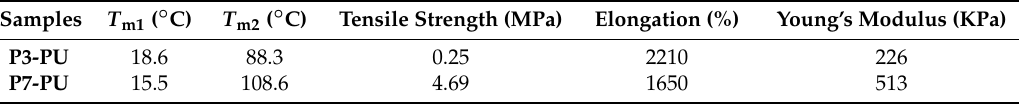
Figure 7. DSC curves of P3-PU and P7-PU . Table 2. Thermal and mechanical properties of peptide-polyurethane/ureas.